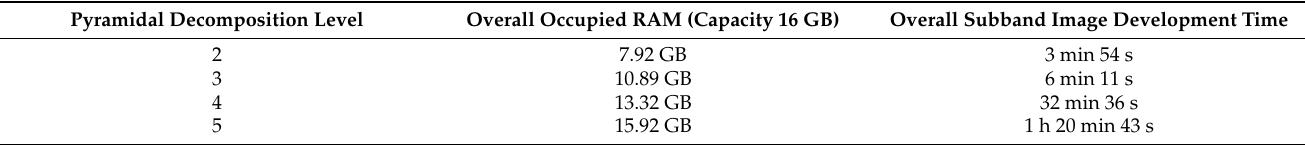
Table 3. The Computational time and RAM consumed in constructing contourlet sub-band coefficients. Pyramidal Decomposition